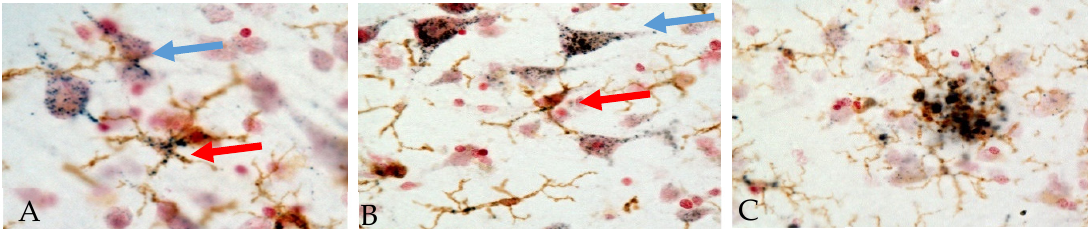
Figure 2. Immunohistochemical localization of PGRN in human temporal cortex. Sections were double-stained with antibody to PGRN (R&D Systems, AF2420) (purple) and the microglia marker IBA-1 (Wako, 019-19741) (brown). The patterns of staining in neurons (blue arrows) and microglia (red arrows) in cells with positive staining for IBA-1 can be seen (Panels A and B). Panel C shows accumulation of microglia (brown) with extracellular PGRN deposits around an amyloid plaque. ( A ) Low pathology control case. ( B ) High pathology control case. ( C ) Alzheimer’s disease case. Staining patterns suggest localization to intracellular vacuoles though plaque staining patterns suggest extracellular aggregates of PGRN.